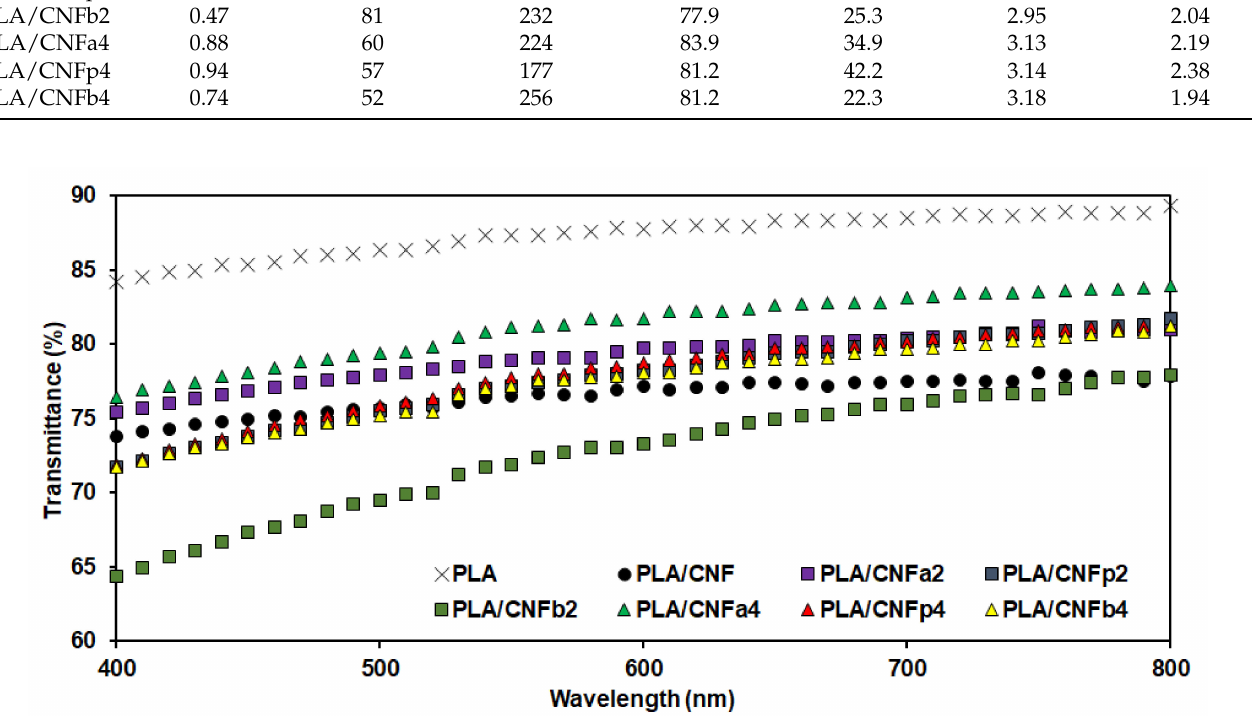
Figure 6. UV–vis transmittance of the PLA/m-CNF composite films (1 g of reactant).